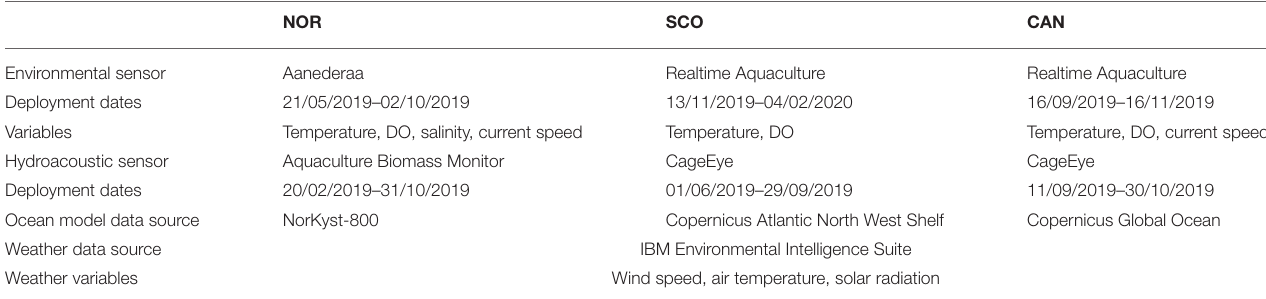
TABLE 2 | Synopsis of data collection at the three sites summarising the environmental variables collected and the sampling periods, source of ocean model data (used to augment sensor data), and weather data source and